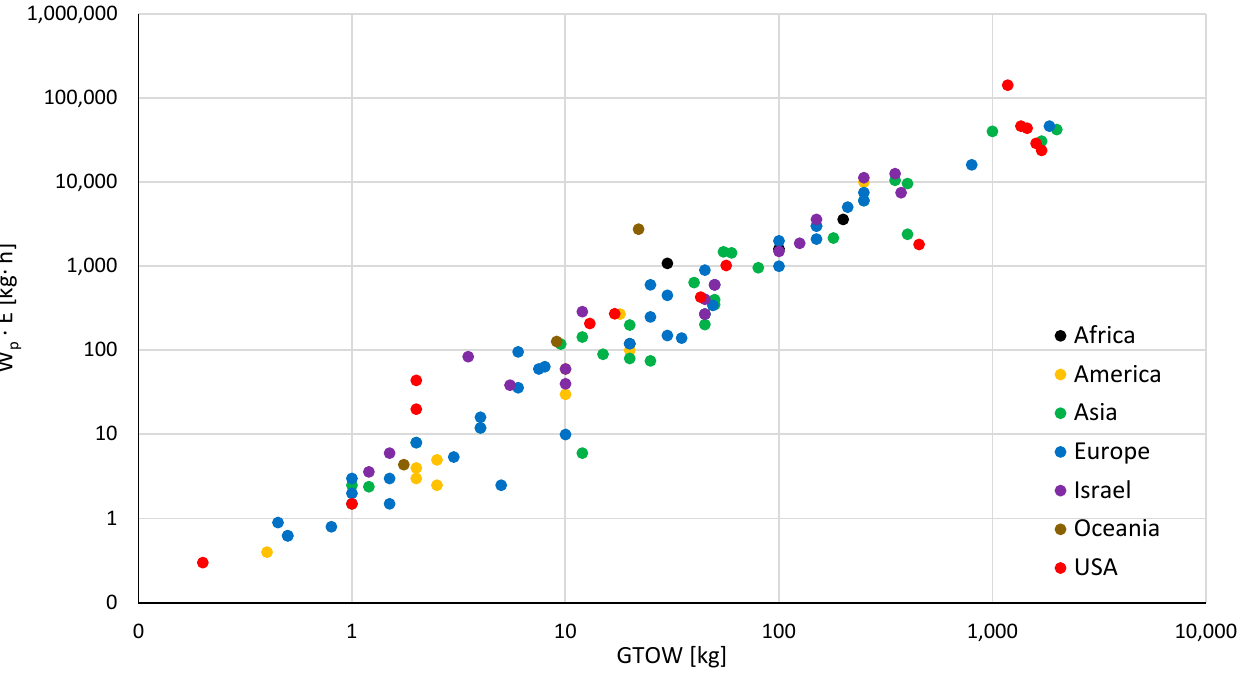
Figure 19. W p · E as a function of GTOW with respect to region of origin. Figures 20 and 21 present the cruise speed parameter as a function of GTOW, while Table 9 sums up the corresponding statistical results.